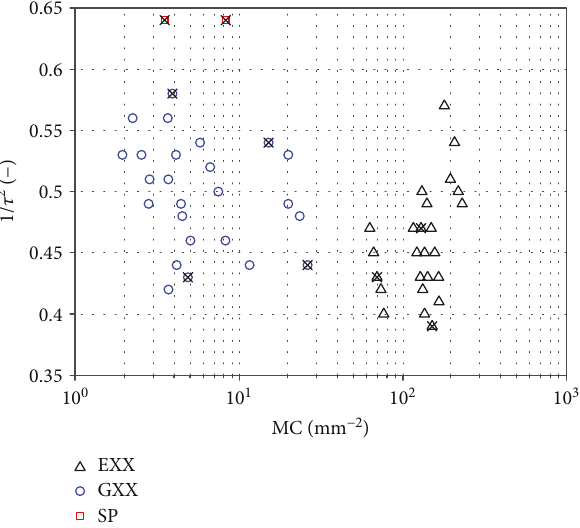
Figure 7: Parameter space of MC and 1/ τ 2 for all generated porous media and CT image sandpack samples, obtained after fl uid fl ow and di ff usion simulations. Crossed markers indicate the sample selected for the advection-di ff usion